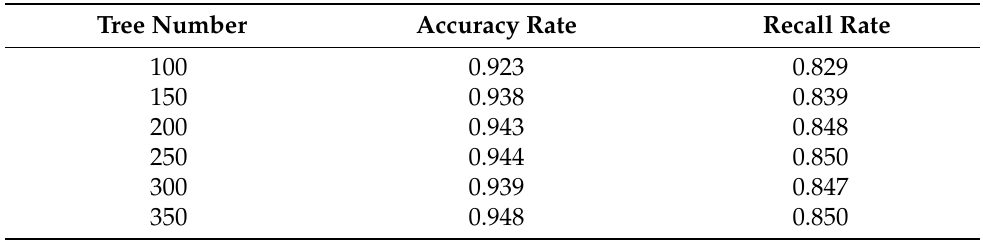
Table 3. The relationship between the number of decision trees and random forest performance after feature extraction.